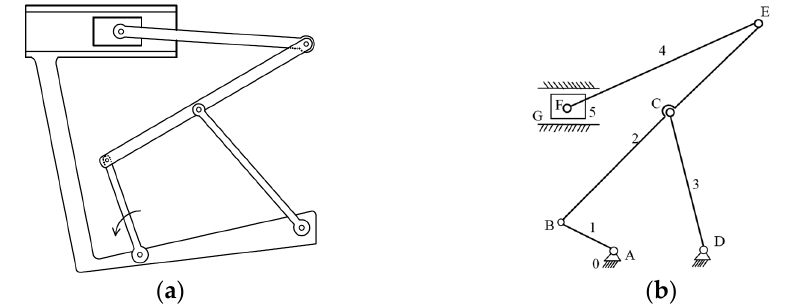
Figure 2. ( a ) Example of mechanism. ( b ) The corresponding structural diagram.